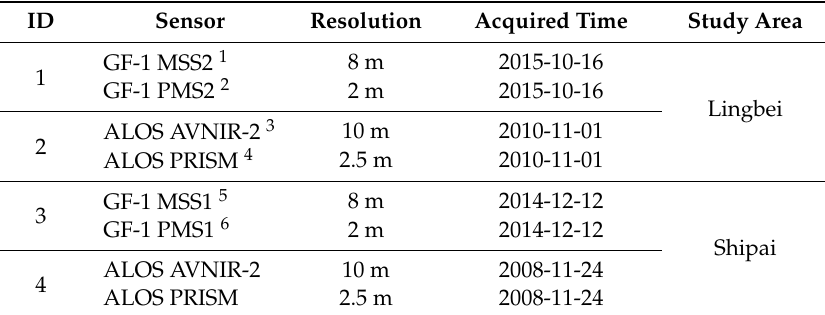
Table 1. Remote sensing images detail list.